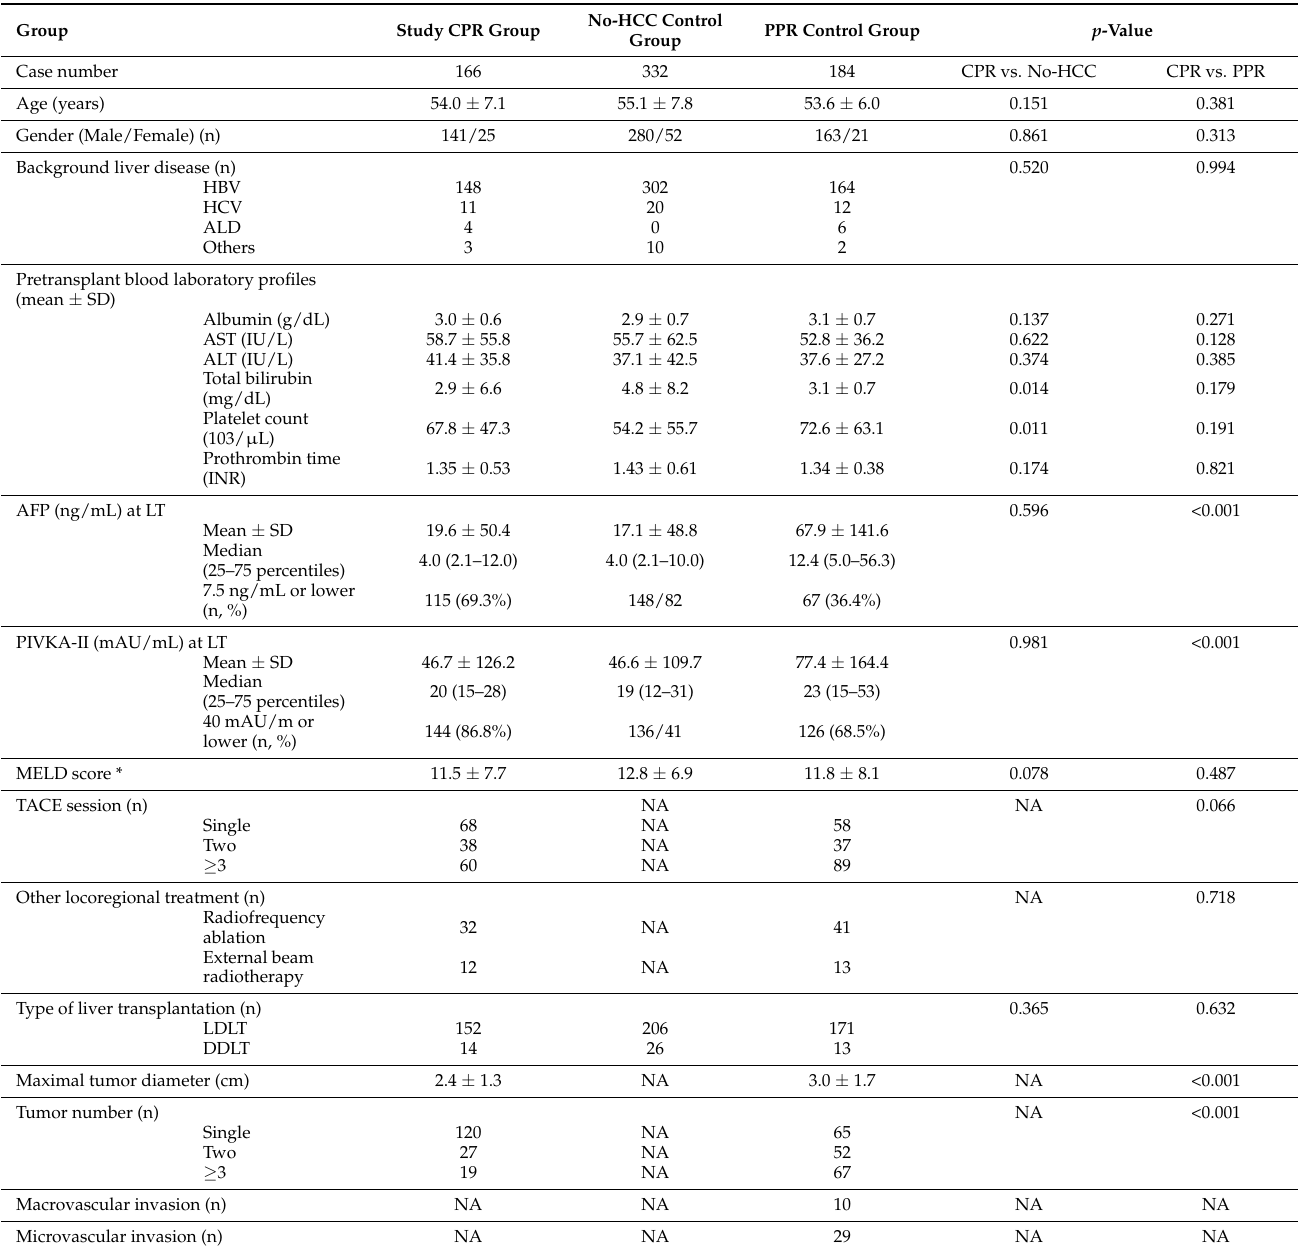
Table 1. Comparison of demographic and tumor characteristics profiles of the CPR study group, no-HCC control group, and PPR control group